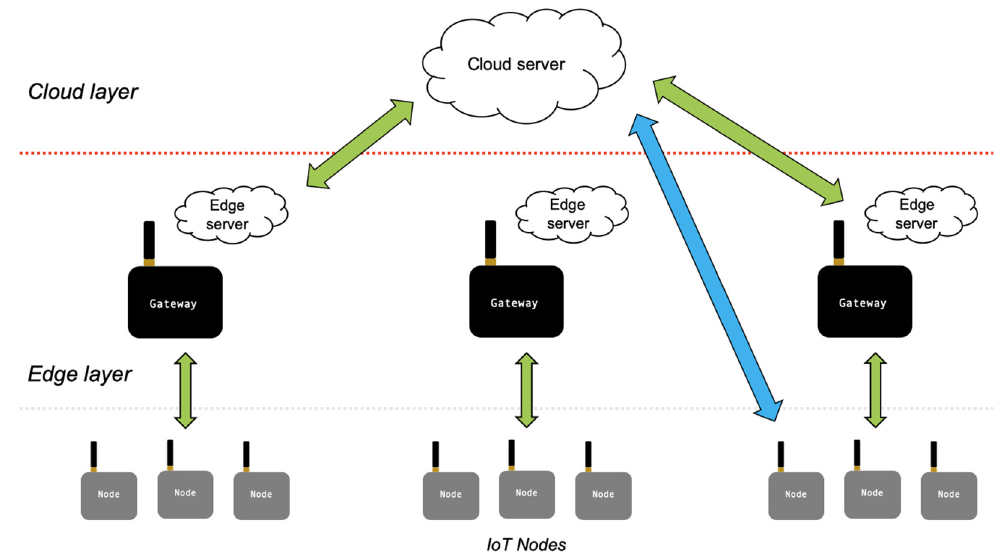
Figure 6. Joint computation among devices, edge, and cloud servers.